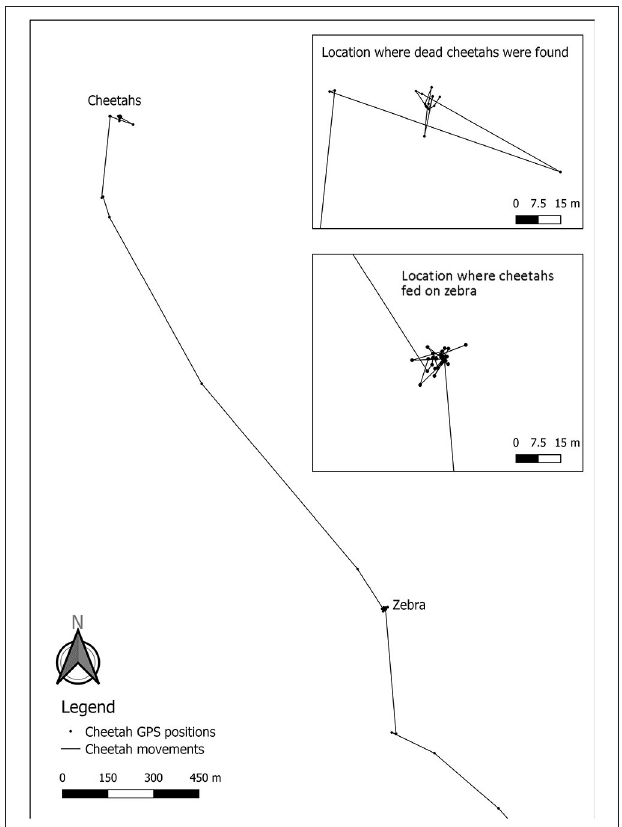
FIGURE 3 | Movements of the GPS collared cheetah 2 days prior to his death. The upper insert shows the GPS clusters of the cheetah the day he died (positions taken every 6h), while the location where cheetahs fed on zebra shows the GPS cluster at the dead mountain zebra (positions taken every 15min). The accuracy of the GPS collar is ∼ 6 meters.